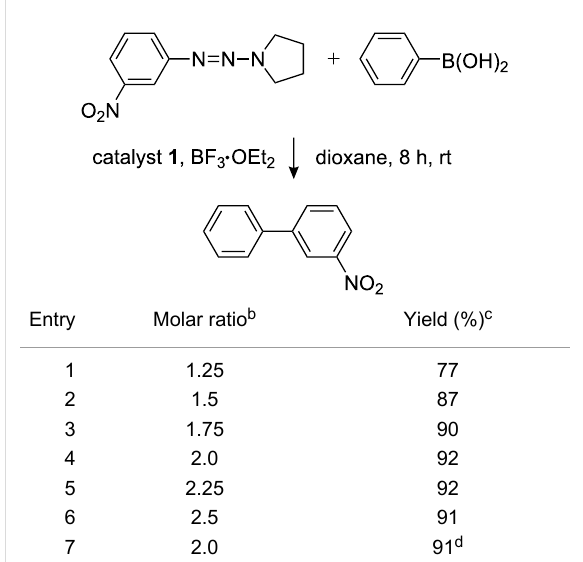
a Reaction conditions: 1-(3-nitrophenyl)-2-(pyrrolidin-1-yl)diazene (0.5 mmol), BF 3 ·OEt 2 (0.5 mmol), catalyst 1 (100 mg, 10 μ mol Pd), dioxane (5 mL), rt, 8 h. b The ratio of phenylboronic acid to1-(3-nitrophenyl)-2-(pyrrolidin-1- yl)diazene. c Isolated by silica-gel column chromatography and based on 1-(3- nitrophenyl)-2-(pyrrolidin-1-yl)diazene. d At 80 °C for 5